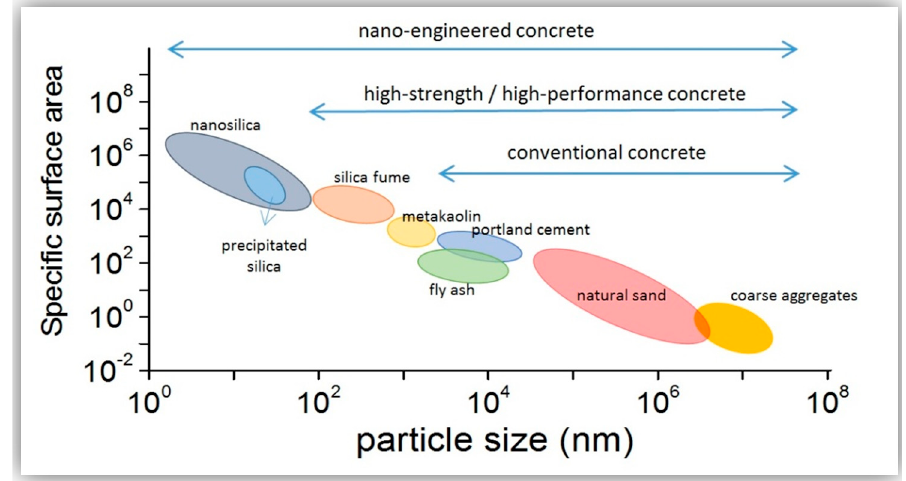
Figure 3. Some kinds of differently-sized particles used for asphalt concrete production.